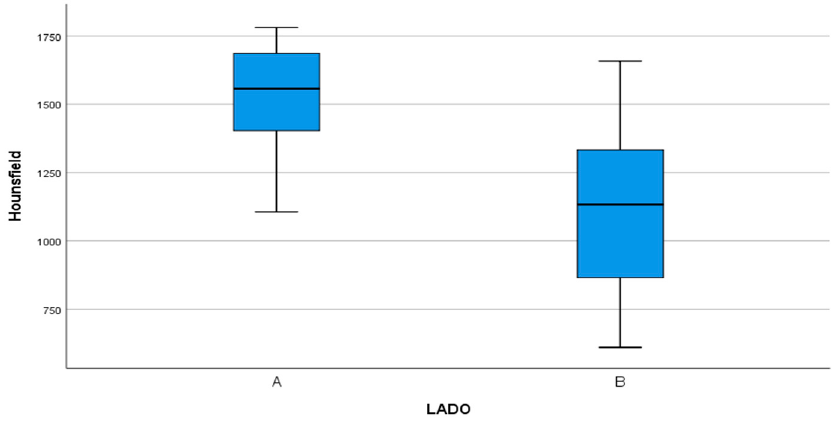
Figure 14. Bone density measured in Hounsfield units in test group (A) compared with control group (B).